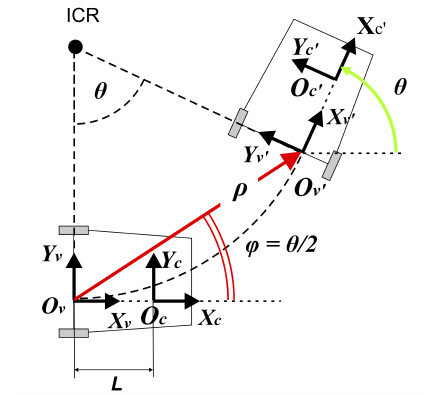
Figure 12: Circular motion of a wheeled vehicle (Scara- muzza,